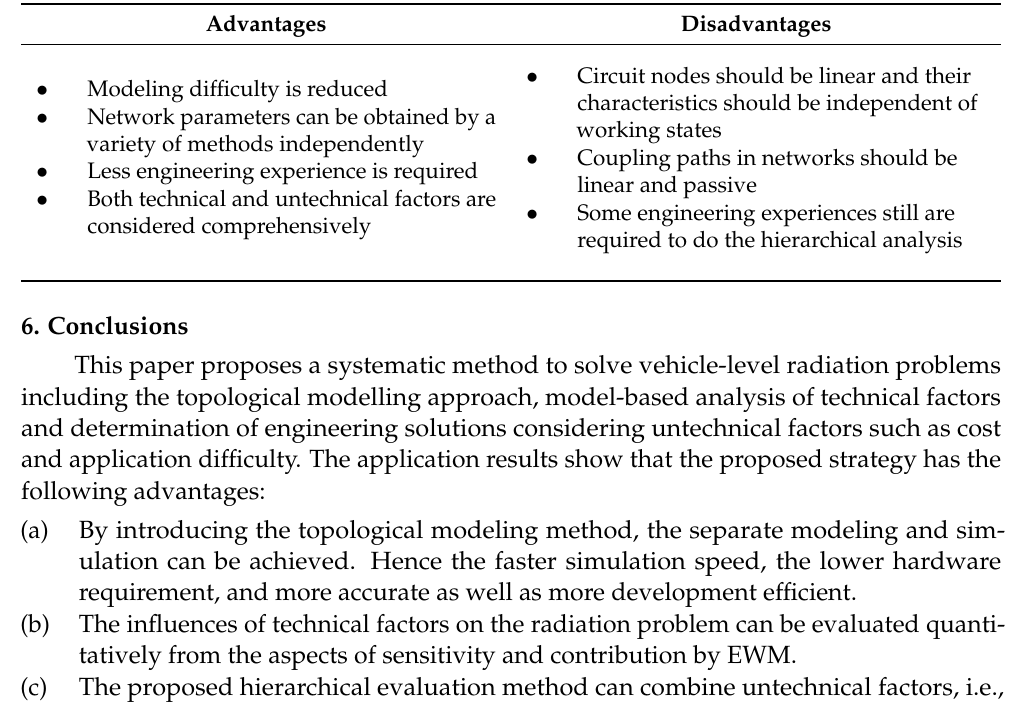
Figure 13. Improvement results of electric field at left side: ( a ) Simulation; ( b ) Experimental test.